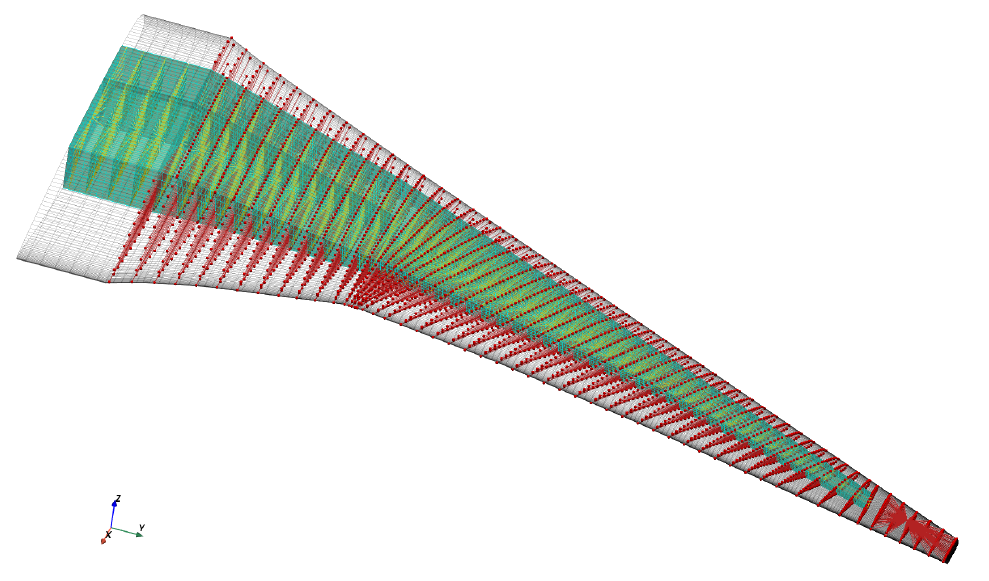
Figure 3. Transport aircraft wing with aero- and structural grids. Coupling nodes in red, structural mesh in green, CFD surface mesh in grey, and RBE3 loads reference assemly in yellow [16].